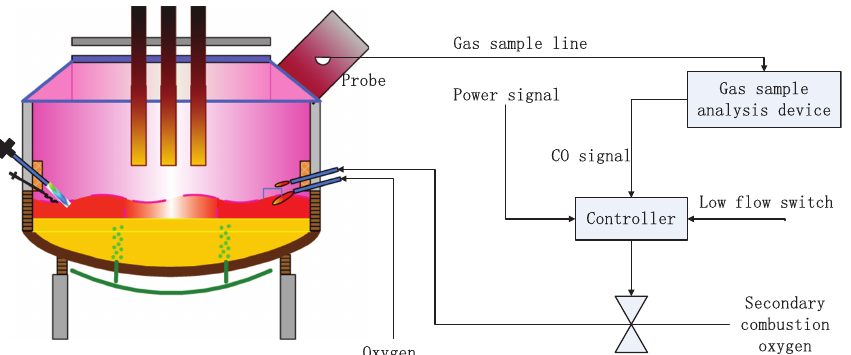
Figure 5: The secondary combustion